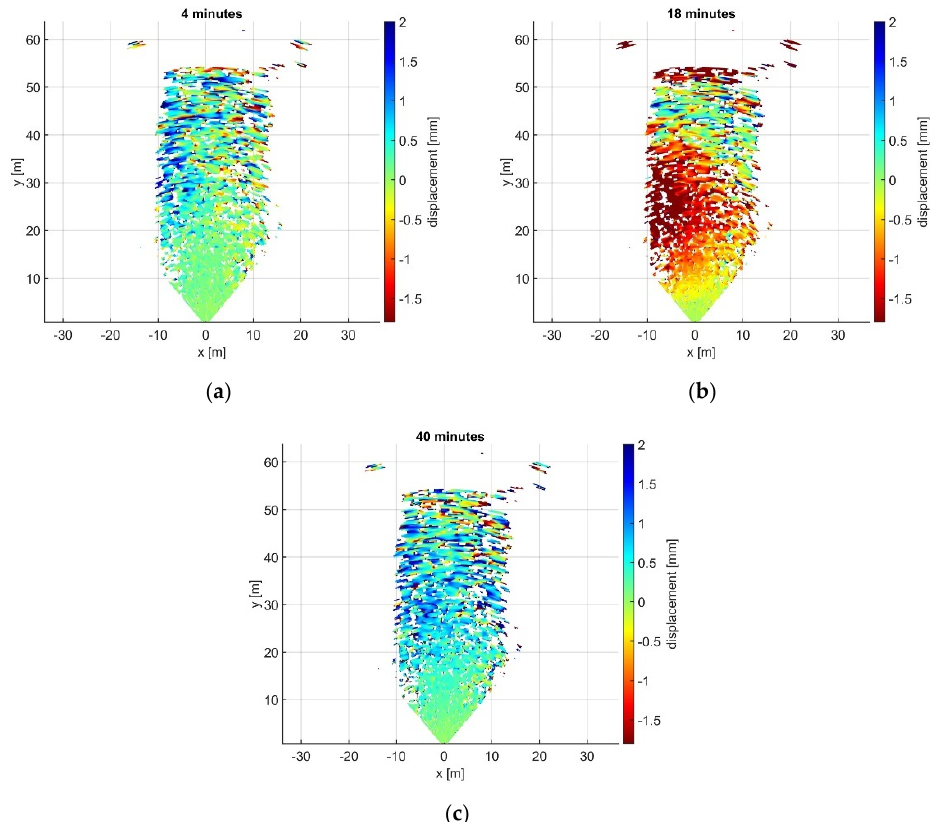
Figure 18. Map of vertical displacement of the bridge deck: ( a ) after 4 min; ( b ) after 18 min; and ( c ) after 40 min.